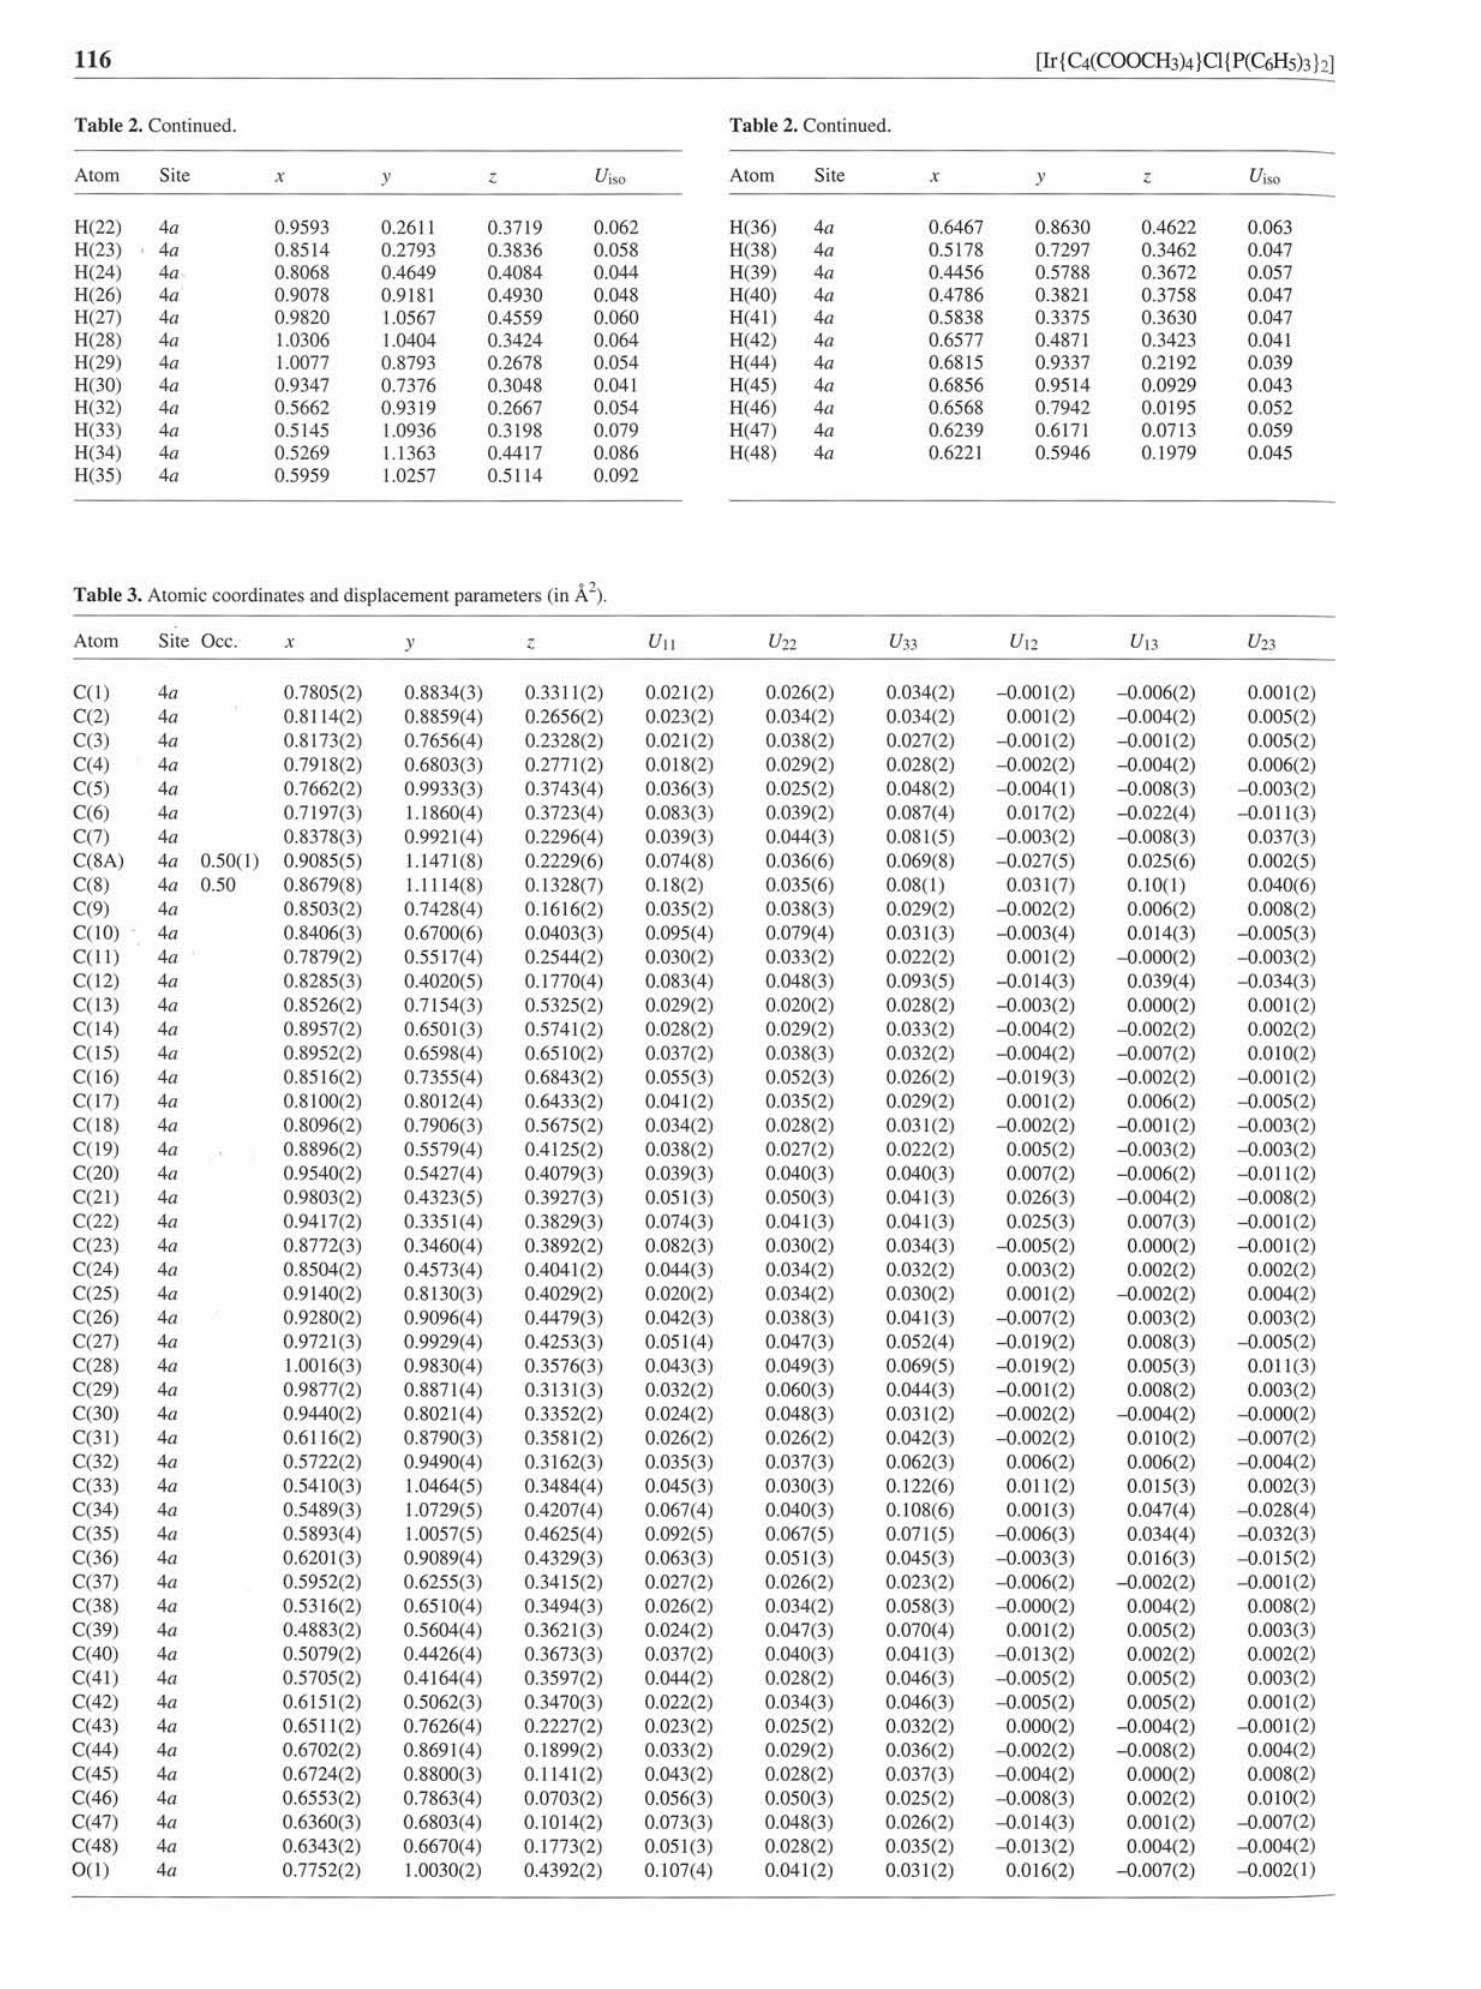
Table 3. Atomic coordinates and displacement parameters (in Â ). Site